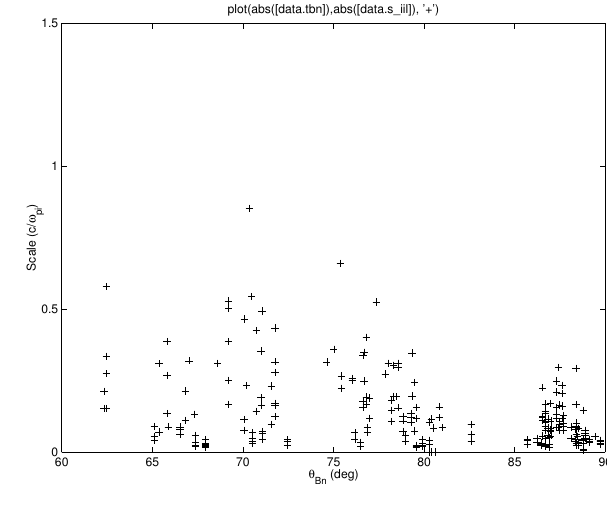
Fig. 8. Histogram of the scale sizes for the spike-like enhancements observed during a number of crossings of the quasi-perpendicular bow shock.